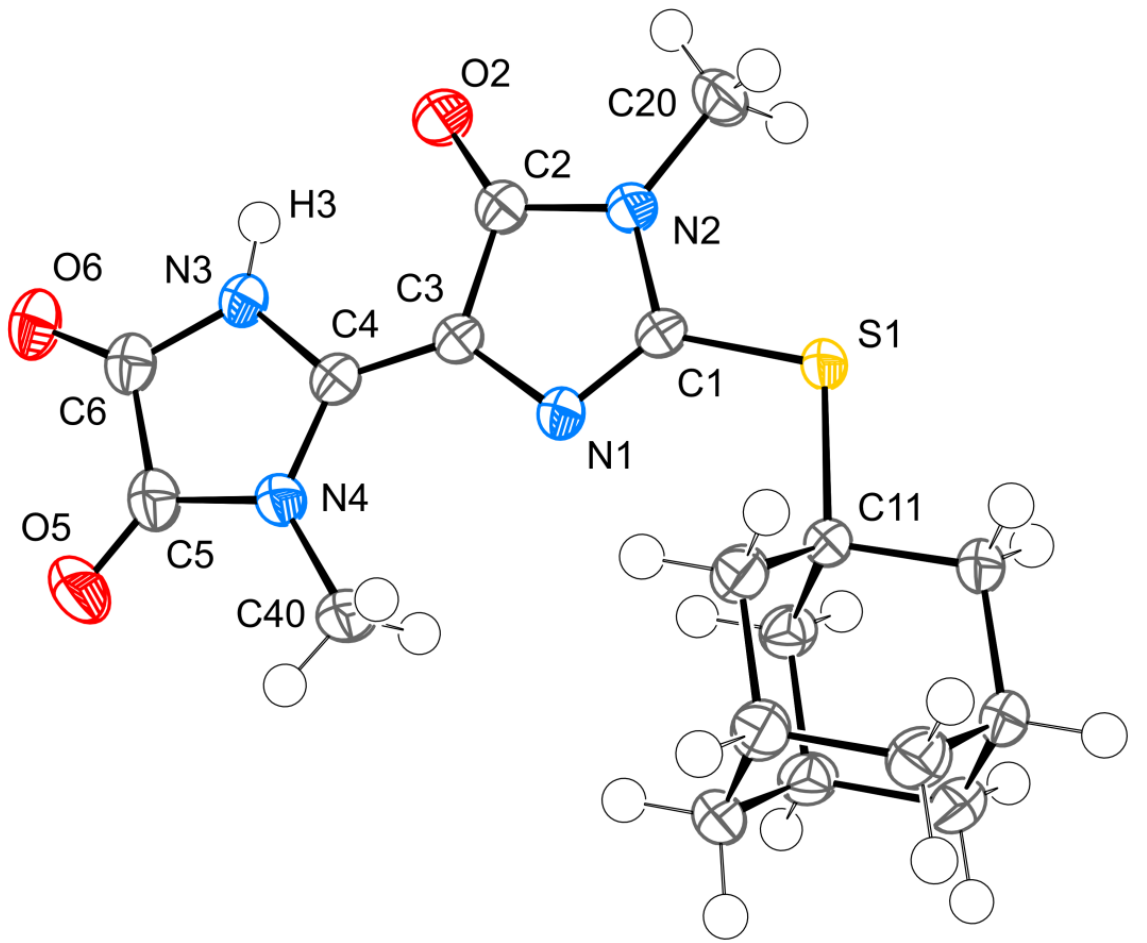
Figure 2. Structure of compound 5 in the crystal with thermal ellipsoids at the 80% probability level for nonhydrogen atoms according to single-crystal X-ray diffraction. Selected interatomic distances